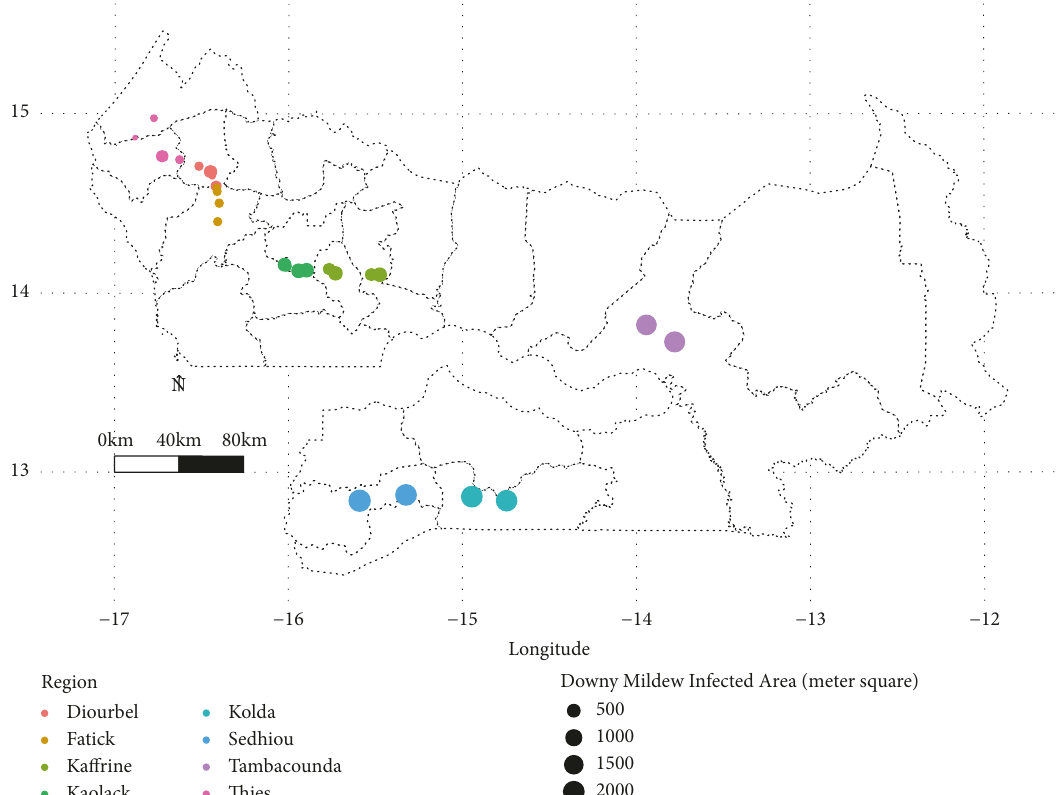
strongly correlated (r = 0.82; p < 0.05) to infected area by downy mildew. Downy mildew incidence and infected area were highly correlated (r = 0.92; p < 0.01) (Figure